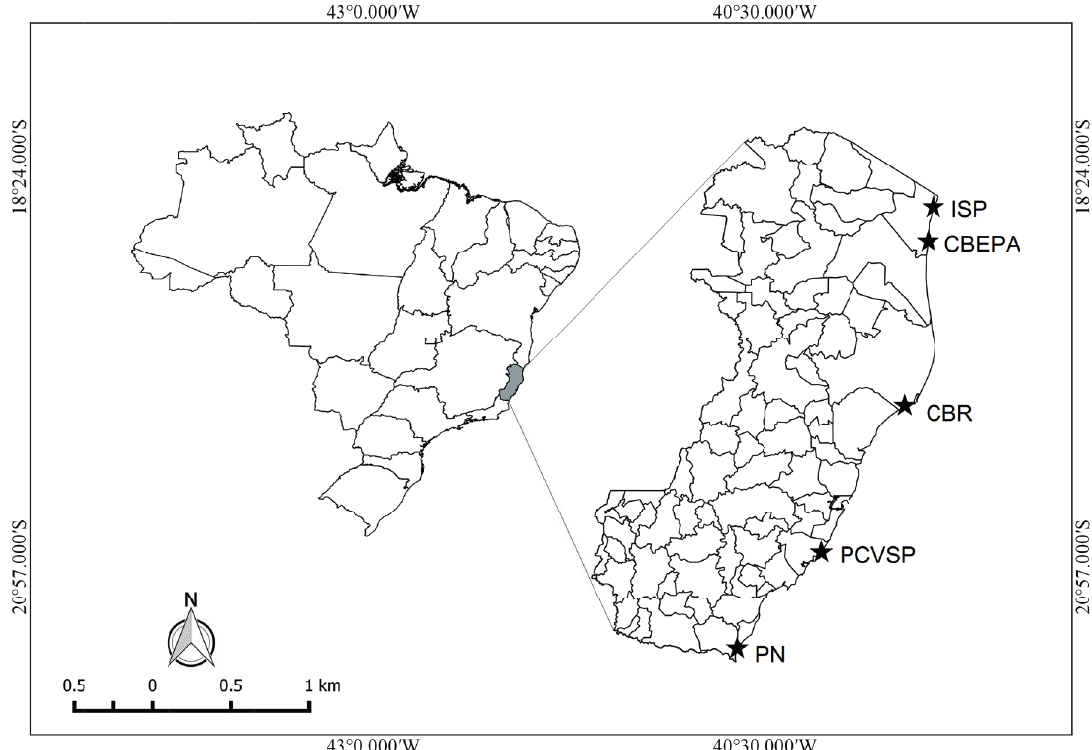
Figure 1 - geographic location of sandy coastal plains remnants studied throughout the state of espírito Santo,